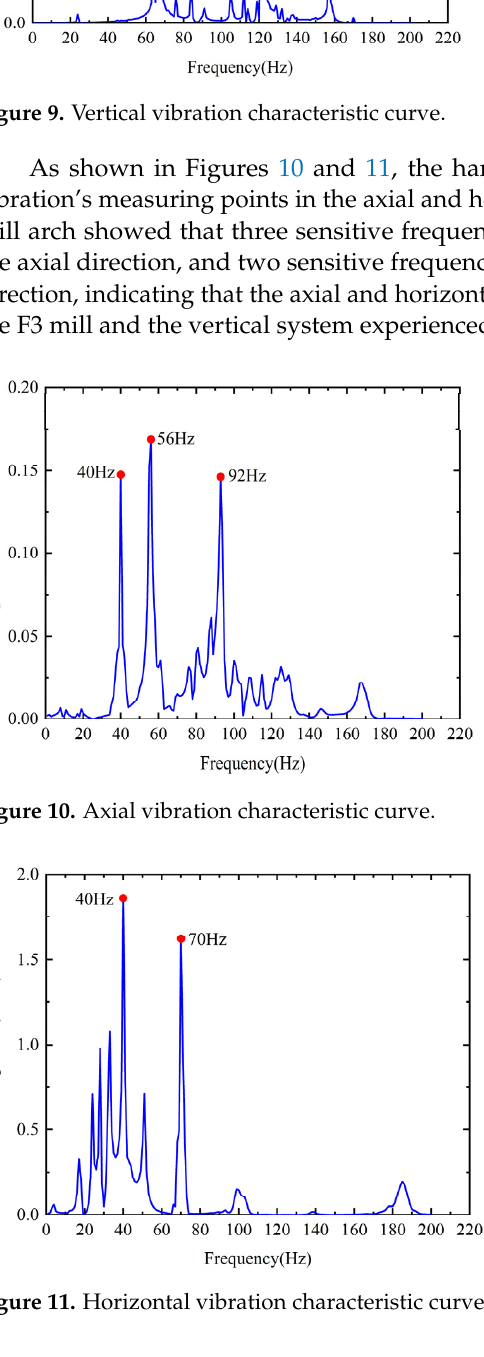
Figure 9. Vertical vibration characteristic curve.